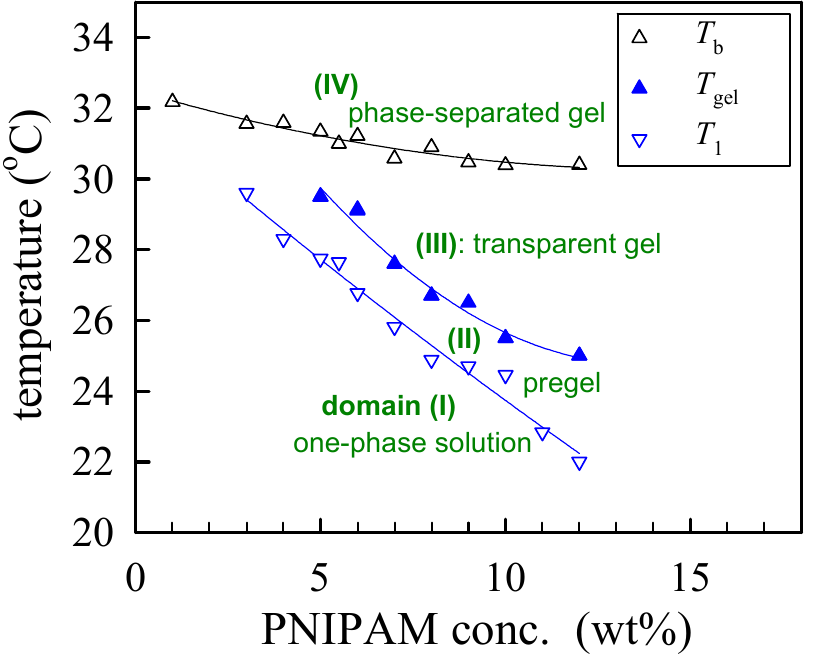
Figure 8. Phase diagram of a-PNIPAM/H 2 O solutions. To further explore the large strain behavior of the a-PNIPAM hydrogel, we performed startup shear experiments on the 9 wt% and 12 wt% samples at a temperature 1 ◦ C higher . γ of 0.05 s − 1 was applied than their corresponding T gel . For both gels, a constant shear rate . γ t ). Figure 9 shows the strain dependence of the growing shear up to a strain of 30 ( γ , = stress ( σ + ). For the 9 wt% gel, a power law dependence of σ + on γ was seen in the initial region up to the strain of 100%, at which the linear viscoelastic limit persisted. Further increases in the applied strain led to strain hardening; σ + finally reached a peak at γ = 2360 and then decreased. Thus, the a-PNIPAM network ruptured at an extremely high strain—a breaking strain much higher than the chemical gels of polydimethylsiloxane (~1000%) [44] and poly (vinyl alcohol) hydrogel (1500%) [45] at their GPs. For the 12 wt% a-PNIPAM networks, similar strain hardening with a higher breaking strain of 3000% was observed. The high breaking strain of an a-PNIPAM network may indicate the existence of a low density of gel junctions with functionality f ≥ 3, as shown in our previous work [38]. Moreover, the lifetime of a gel junction must be longer than the time scale of an applied shear rate (~20 s). These results suggest the existence of strong bonding energy in the gel junctions that resist junction breaking before network rupture at high shear strains of 24–30. Thus, a-PNIPAM hydrogel exhibits strong junction strength and demonstrates permanent elasticity at T gel < T < T b . This is in great contrast with the transient gel of telechelic PNIPAM [46], which is exclusively involved with van der Waals force within micellar